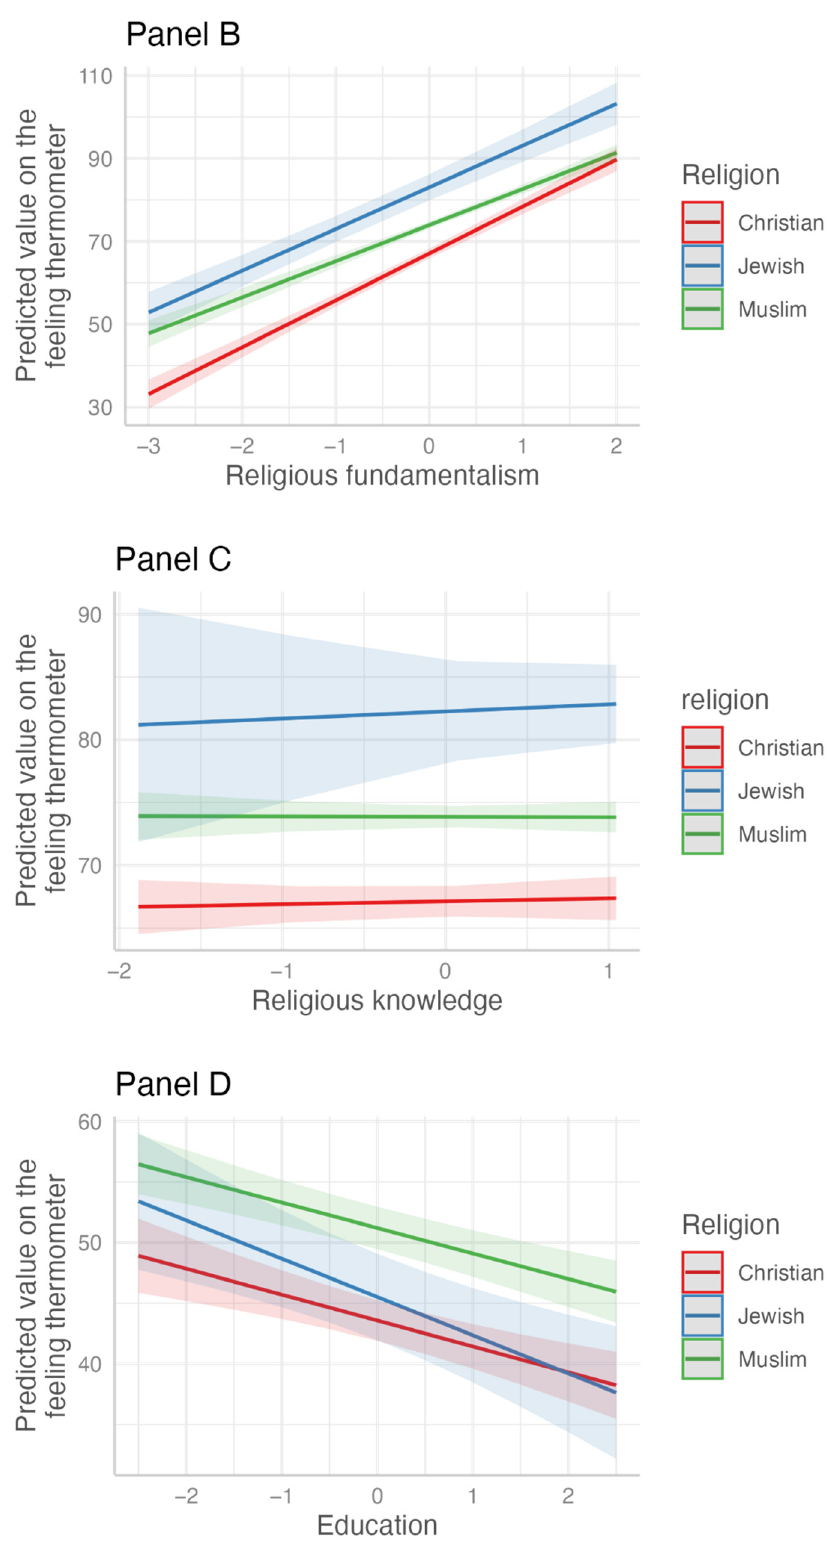
Figure 1. Predicted feeling thermometer scores for converts conditional on the values of religious practice ( Panel A ), religious fundamentalism ( Panel B ), religious knowledge ( Panel C ), and education ( Panel D ) across religious groups .